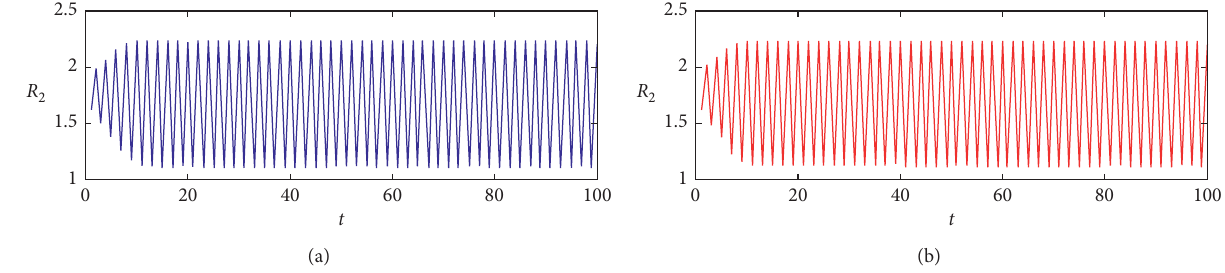
Figure 12: Orbits of R